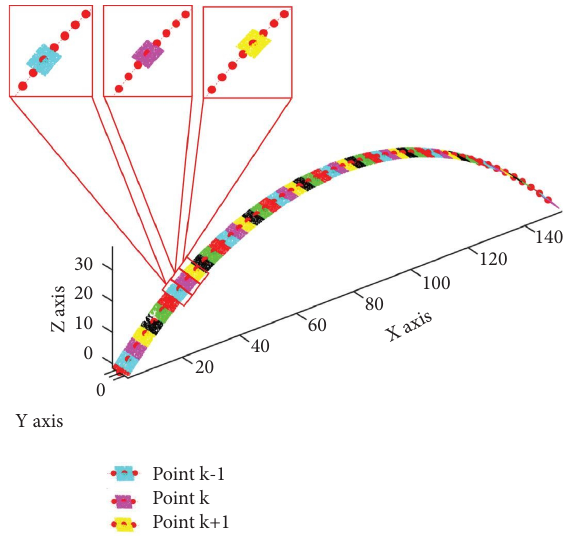
Figure 4: Slide window algorithm.